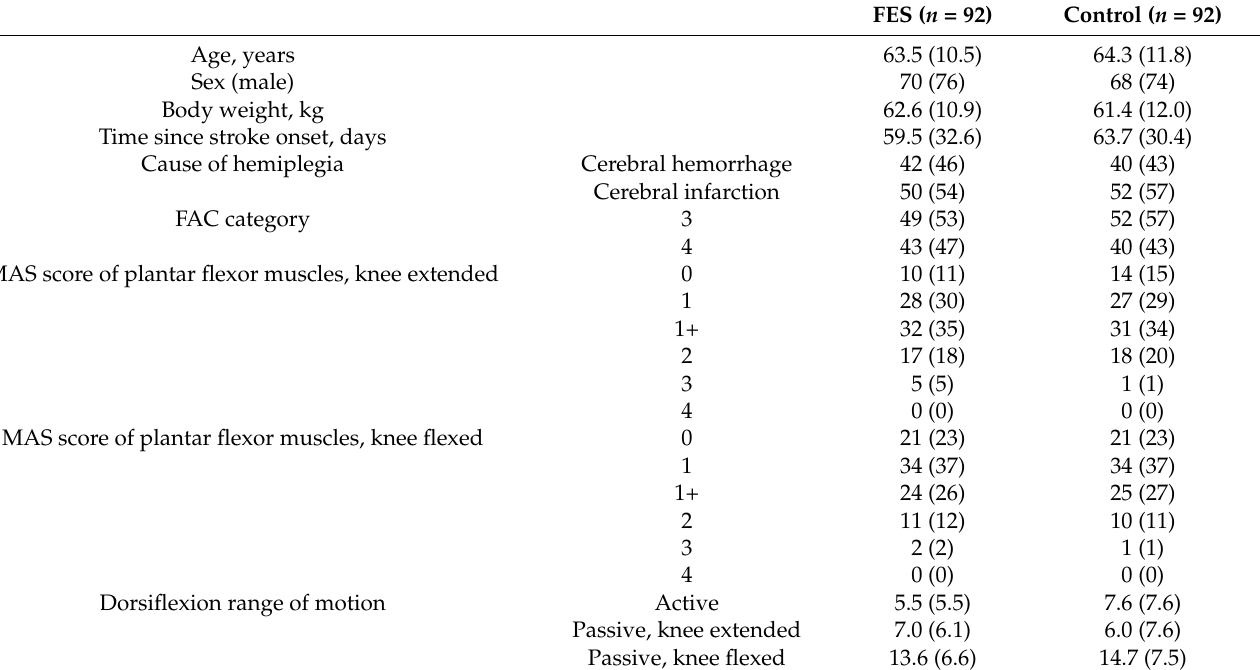
Figure 1. Trial profile. Abbreviation: FES, functional electrical stimulation. Table 1. Baseline characteristics by treatment allocation. Data are presented as means (SDs) or n (%). Abbreviations: FAC, functional ambulation classification; MAS, modified Ashworth scale; SD, standard